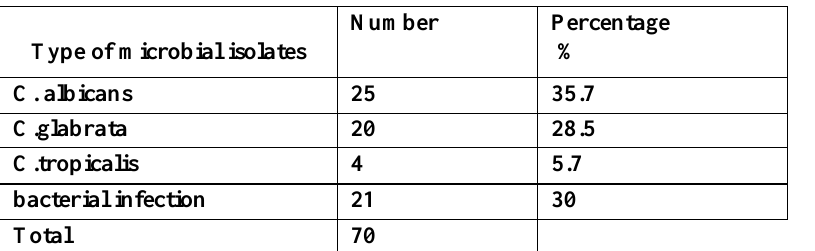
Table 1: number of fungal and bacterial isolated and percentage from the vaginal swabs